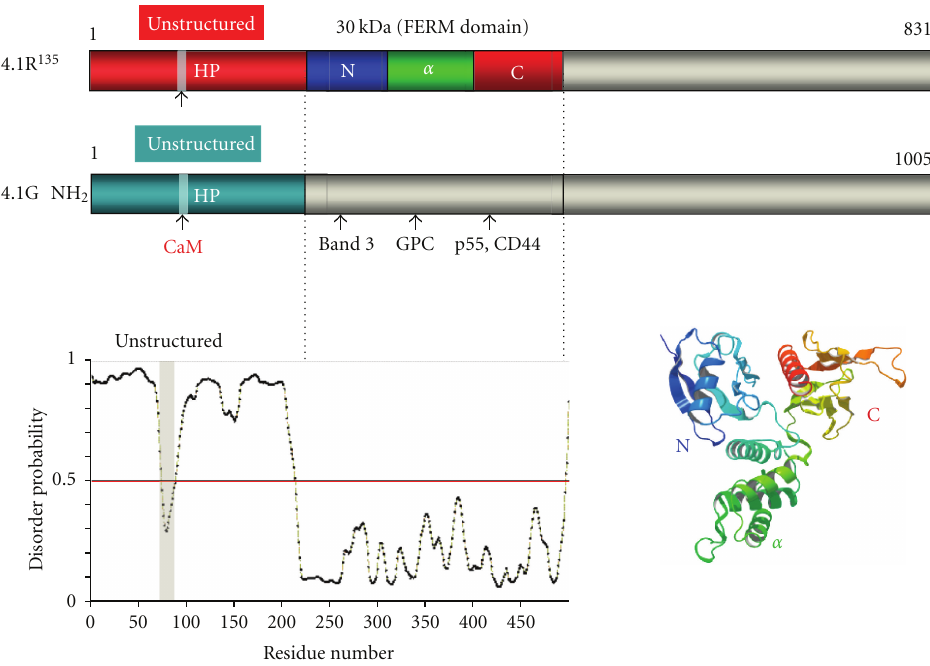
Figure 8: Primary structure of 4.1G. The primary structure of 4.1G resembles that of 4.1R 135 . In vitro binding assays show that the 30 kDa domain of 4.1G binds to previously characterized 4.1R binding partners. Modeling of 4.1G FERM domain 3D structure was performed in silico [41] . Spectrin and actin binding sites in 4.1G C-terminal domain are not